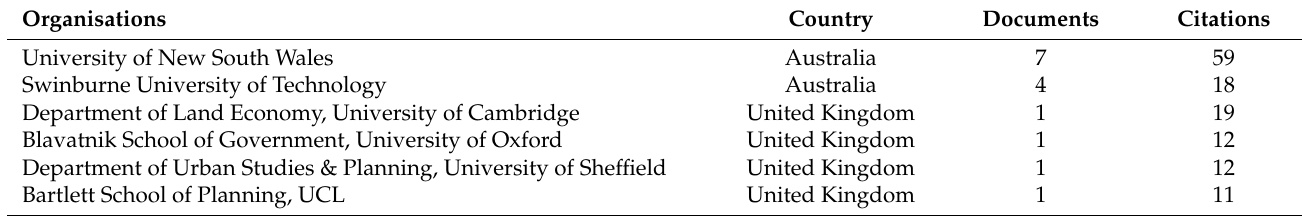
Table 7. Organisational analysis of retrieved BTR research articles.